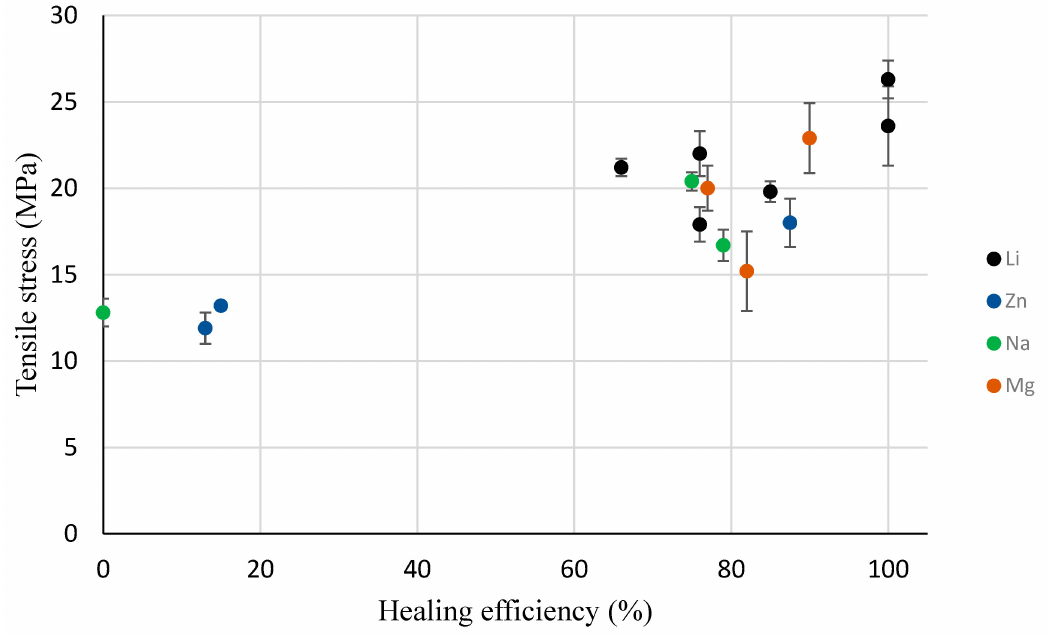
Figure 16. Tensile stress at maximum load for all PEMAA polymers at 25 ◦ C in relation to the healing